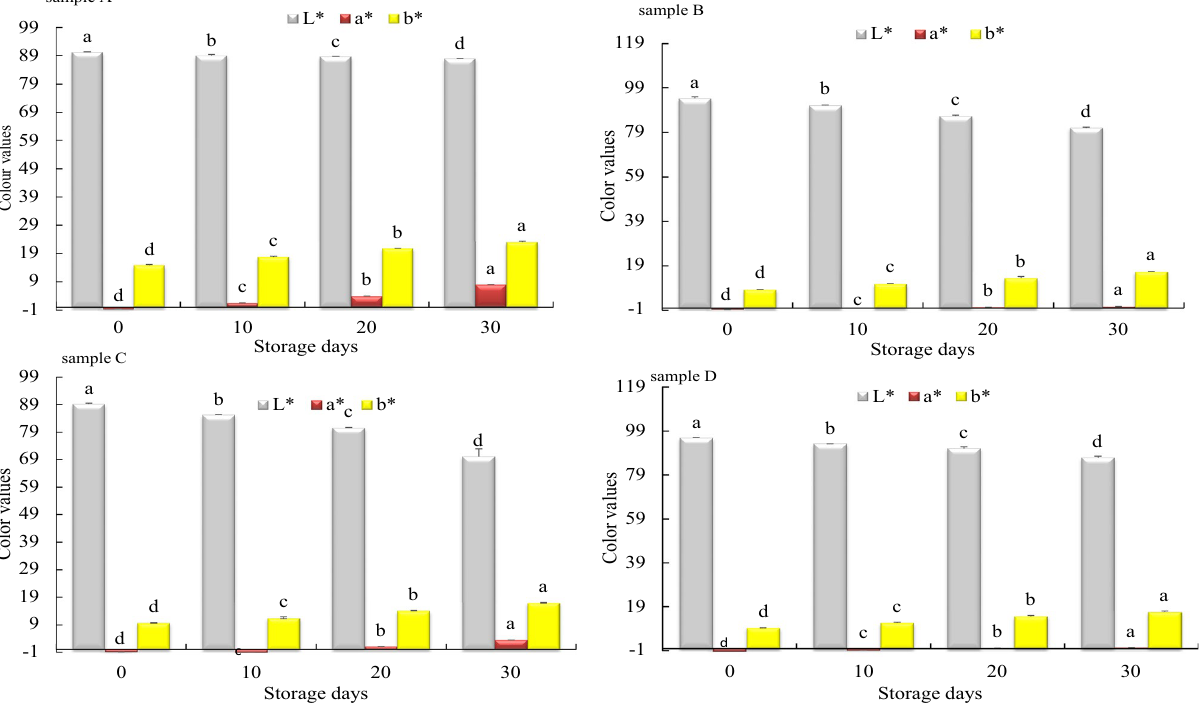
Storage Figure 1. Changes in color values of yak butter powders during accelerated storage. “a,b,c,d” indicate significant differences within yak butter powders at p <